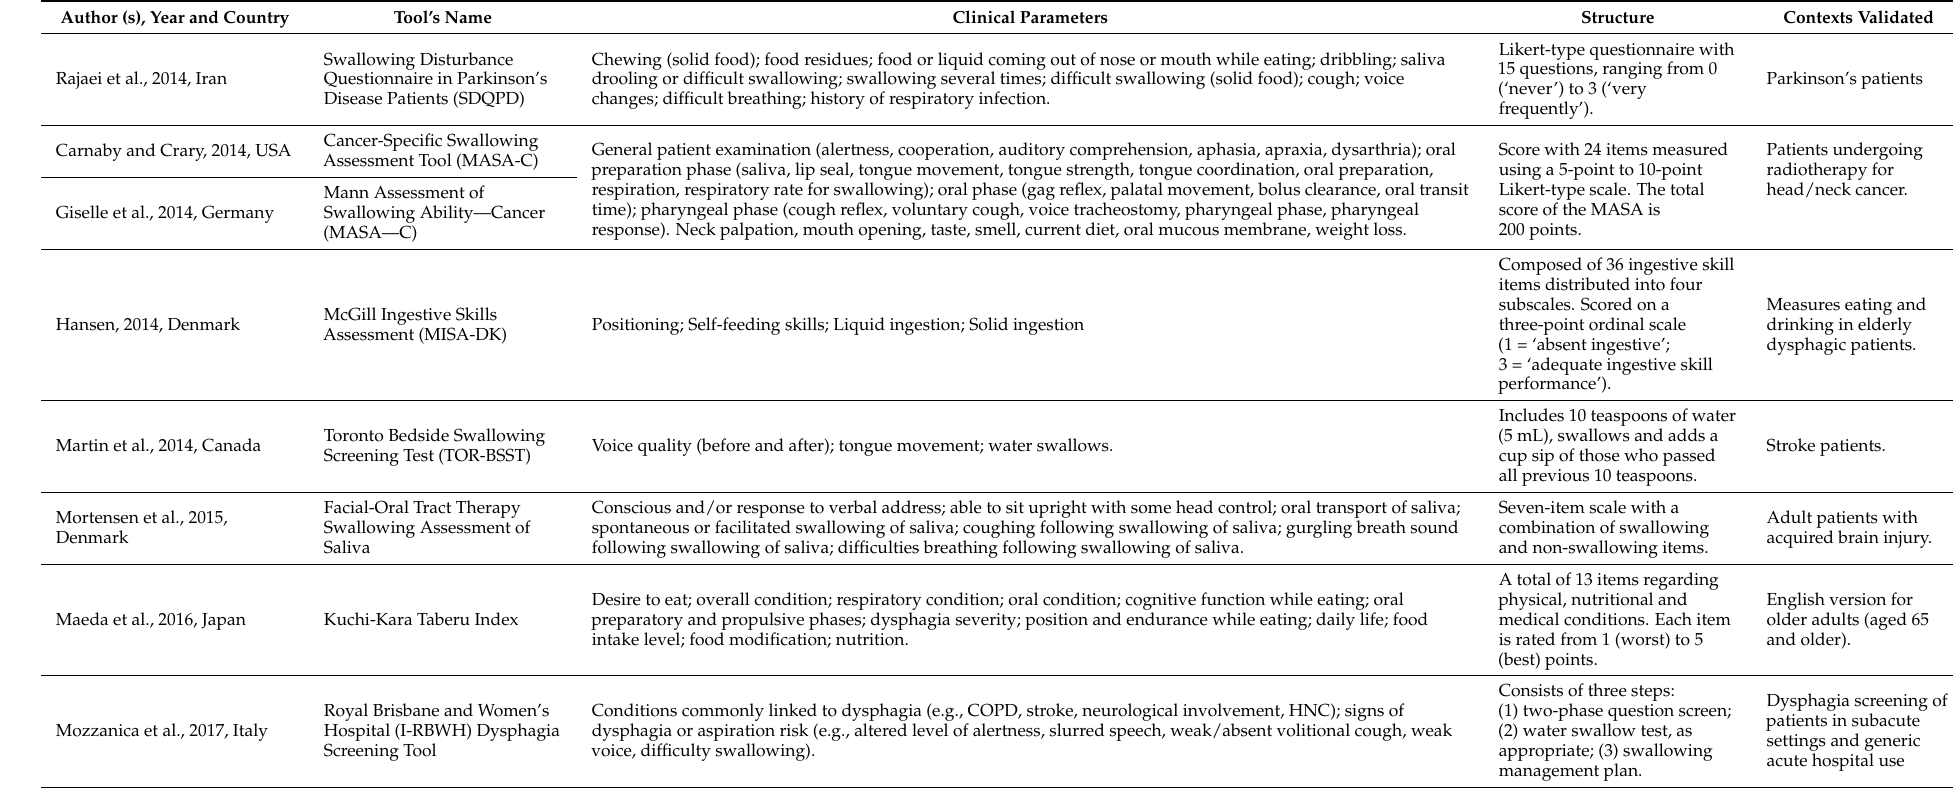
Table 2. Summary of the included studies ( n =